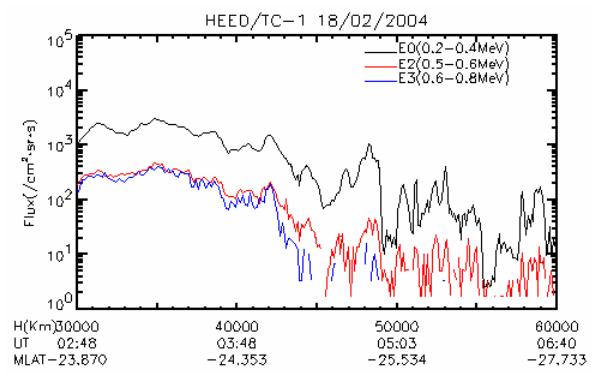
Fig. 8. The minute-averaged high energy electron flux in energy channels E0, E2 and E3 observed by HEED/TC-1 on 18 February